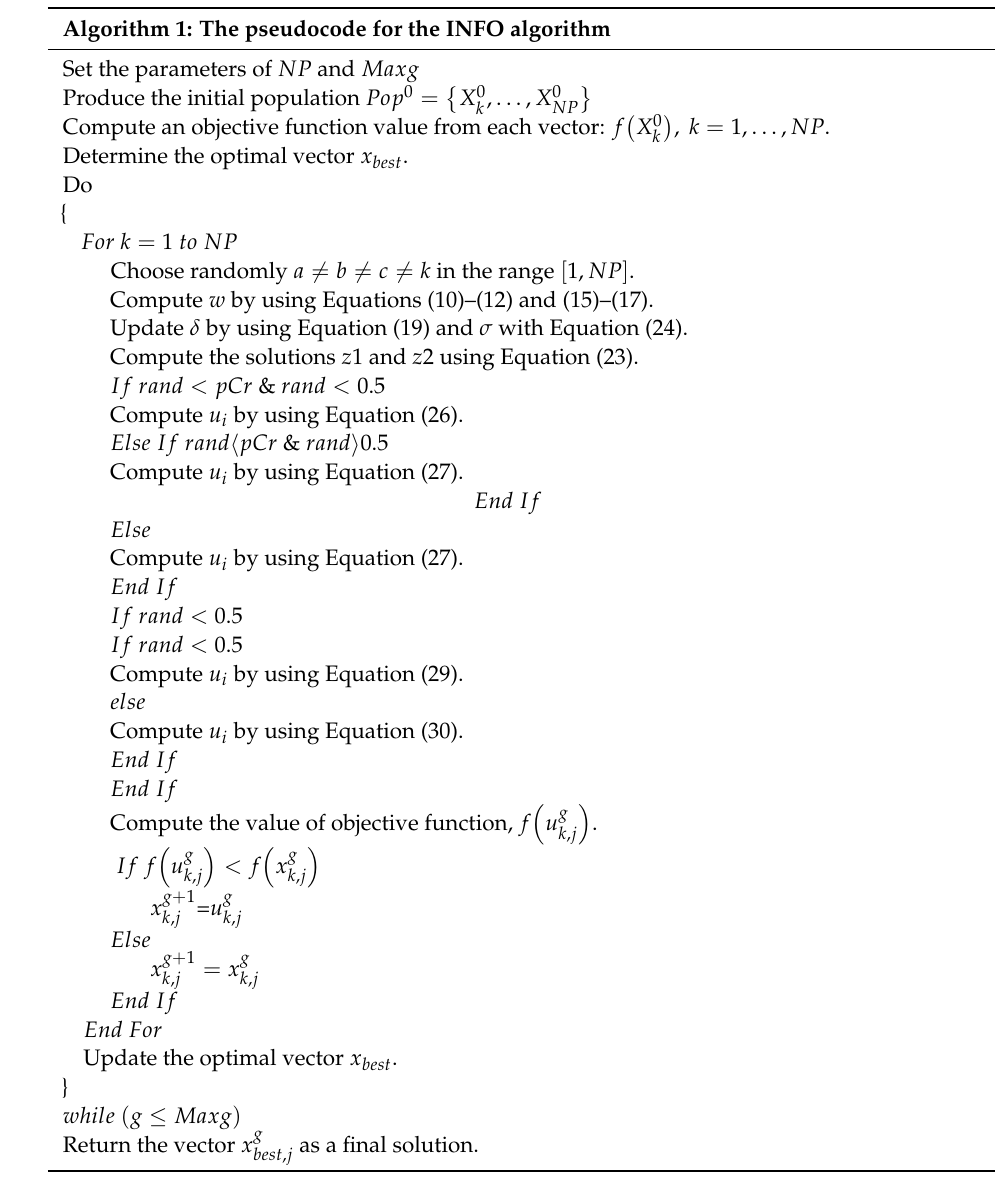
Algorithm 1: The pseudocode for the INFO